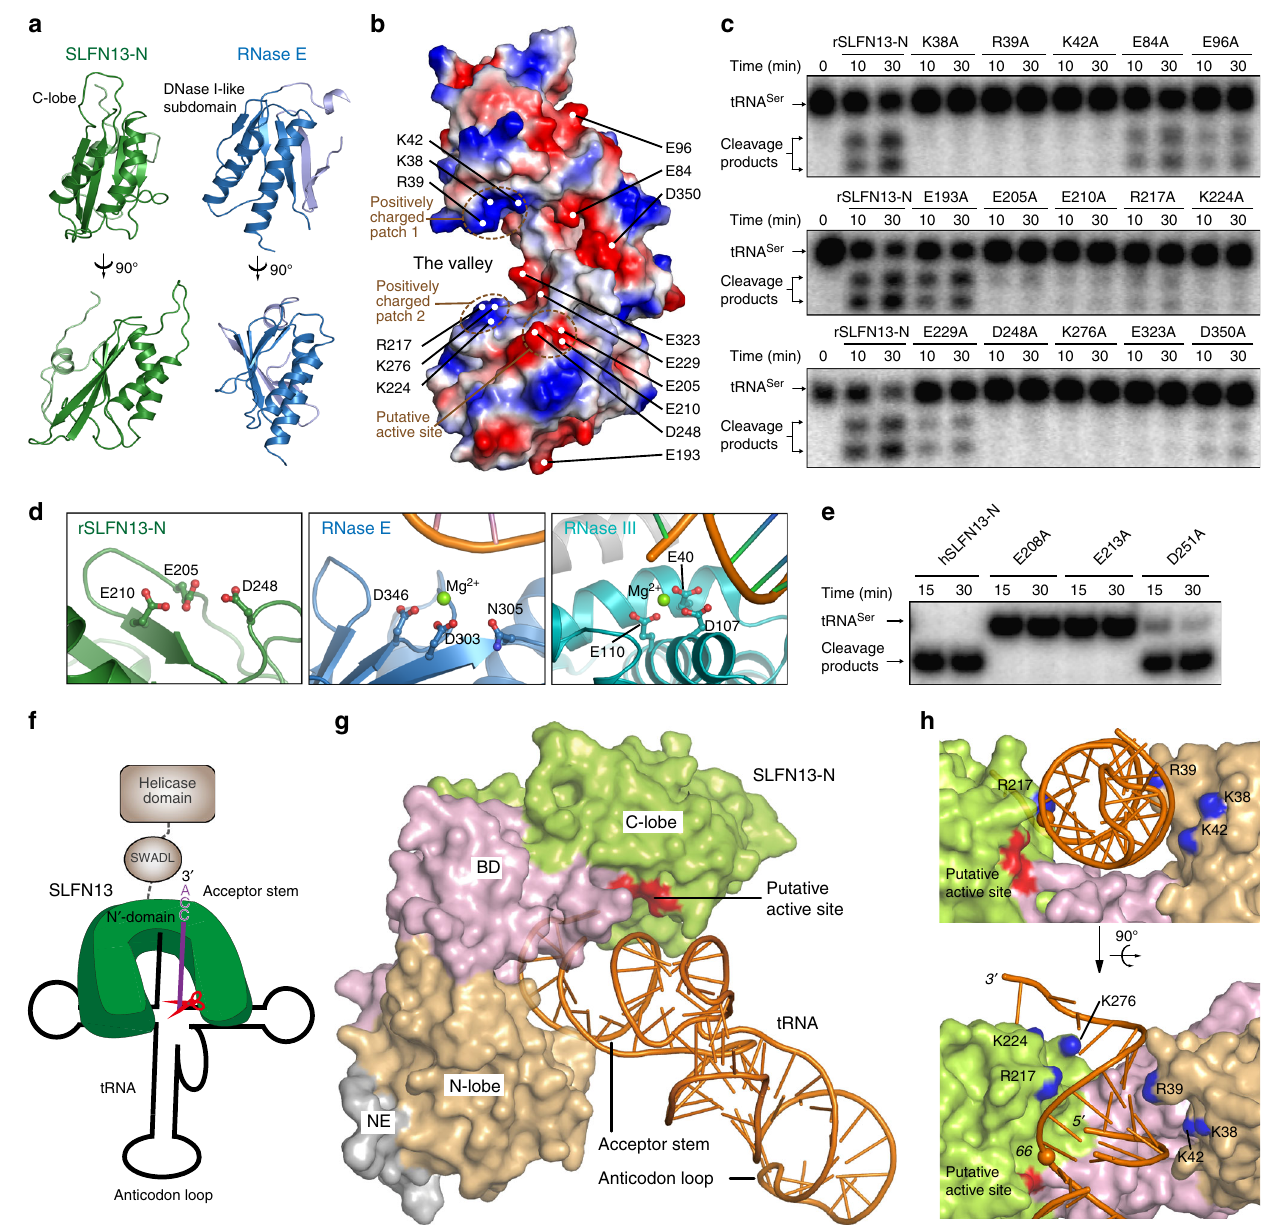
Fig. 3 Putative catalytic site and cleavage model of SLFN13-N. a Structural comparison between the C-lobe of rSLFN13 14 – 353 and the DNase I subdomain of RNase E (PDB ID 2BX2). For RNase E, the portion that is structurally aligned to rSLFN13 14 – 353 C-lobe is shown in blue, and the rest part in light blue. b The electrostatic surface potentials of rSLFN13 14 – 353 , coloured from red (negative) to blue (positive). Two negatively charged patches and the conserved positively charged area are indicated. Positions of the residues tested in c are speci fi ed. c tRNA cleavage assay for rSLFN13 1 – 353 mutants of conserved charged residues in the presence of Mg 2 + . For each sample, 500 nM protein was used. d Comparison between the putative nucleolytic active site of rSLFN13-N and the actives sites of RNase E (2BX2) and RNase III (2EZ6). Note the similar tripod architecture of the three residues for each protein, which are shown as ball-and-stick models. e Cleavage assay of hSLFN13 1 – 355 mutants at the putative active site. E208A, E213A and D251A of hSLFN13-N correspond to E205, E210 and D248 of rSLFN13-N, respectively. f Schematic drawing of SLFN13 cleaving a tRNA. The U-pillow-shaped SLFN13 N ′ -domain embraces the acceptor stem of the tRNA. The 3 ′ tail that is to be cleaved off the tRNA by SLFN13-N is coloured purple. g Structural model of SLFN13-N manipulating tRNA. rSLFN13 14 – 353 is shown as surface representations and the subdomains are colour-speci fi ed. The putative active site is coloured red. The coordinate of tRNA Gly (5E6M, excerpted) is used and coloured orange. SLFN13-N clamps the acceptor stem of tRNA and may have no contact with other parts of the tRNA. h Close view of SLFN13-N accommodating the acceptor stem. The surface positively charged residues of rSLFN13 14 – 353 tested in c are coloured blue. Part of the tRNA is removed for clarity. The 5 ′ and 3 ′ ends of the tRNA are indicated. The phosphate atom of the 66th nucleotide of tRNA is shown as a